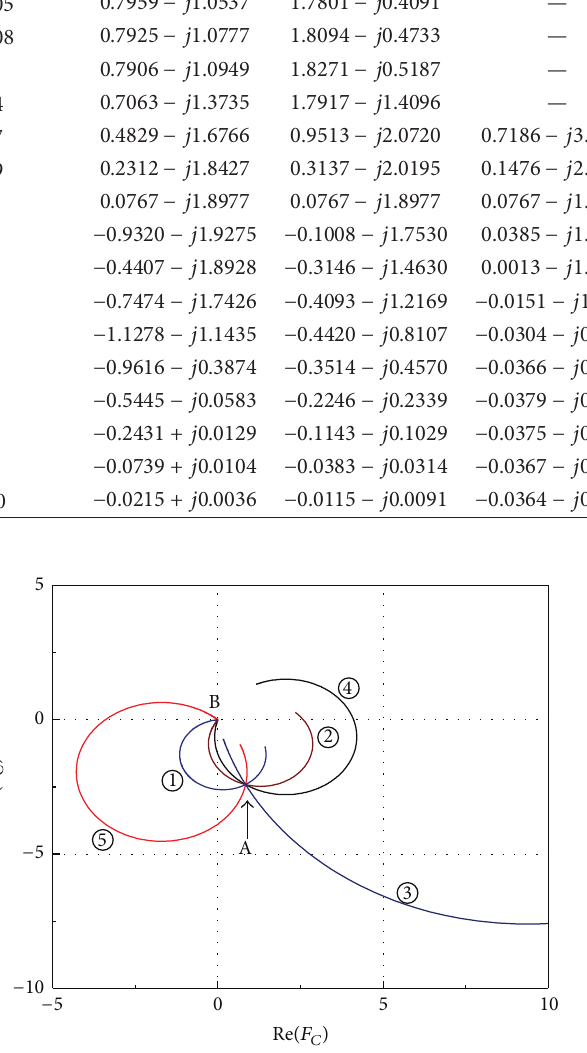
Figure 3: 2D collaborative fault model of the Sallen-Key filter. All potential fault statuses of the filter compose a family of 𝐹 𝑖 -loci, and 𝐹 𝑖 -loci converge in the fault free point A and zero point B.